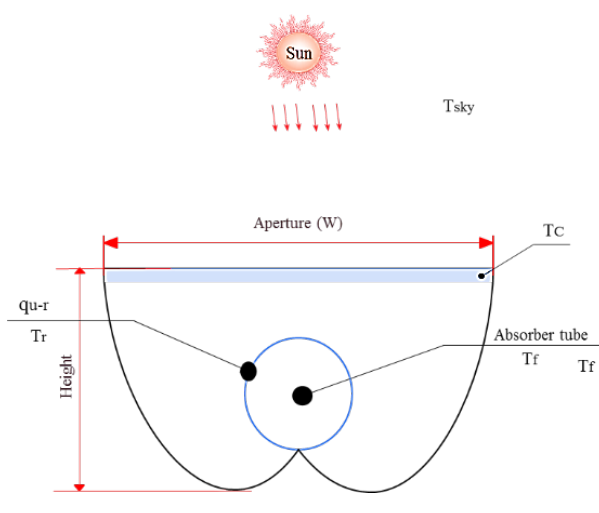
Figure 1. CPC collector